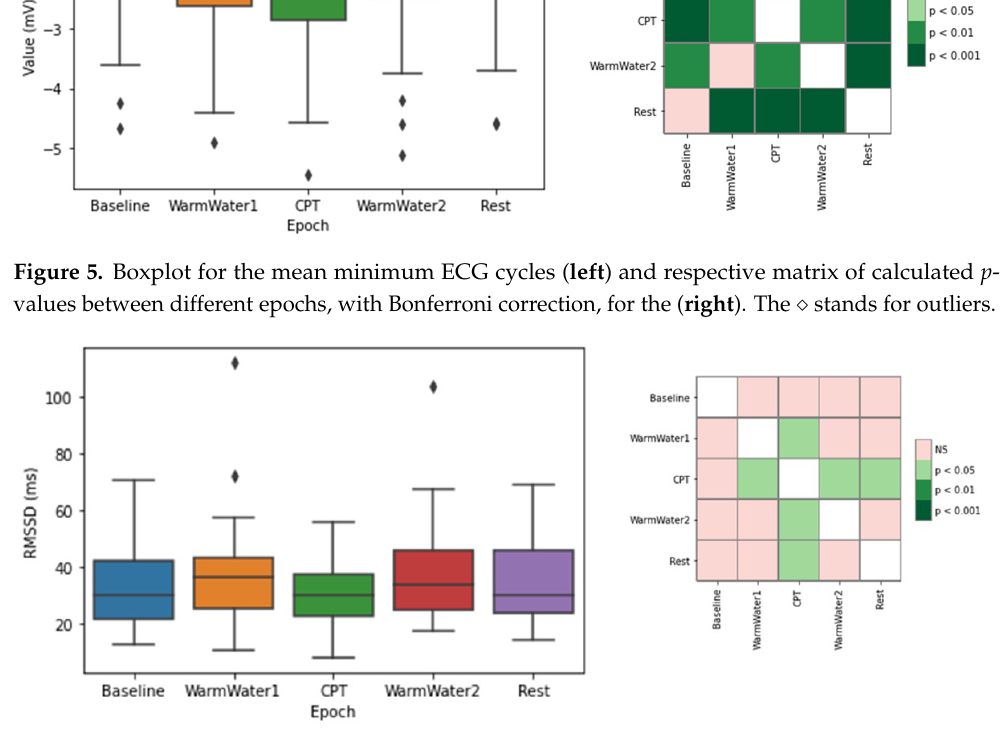
Figure 6. Boxplot of RMSSD values for each epoch ( left ) and respective p -values between different epochs, with Bonferroni correction ( right ). The (cid:5) stands for outliers.